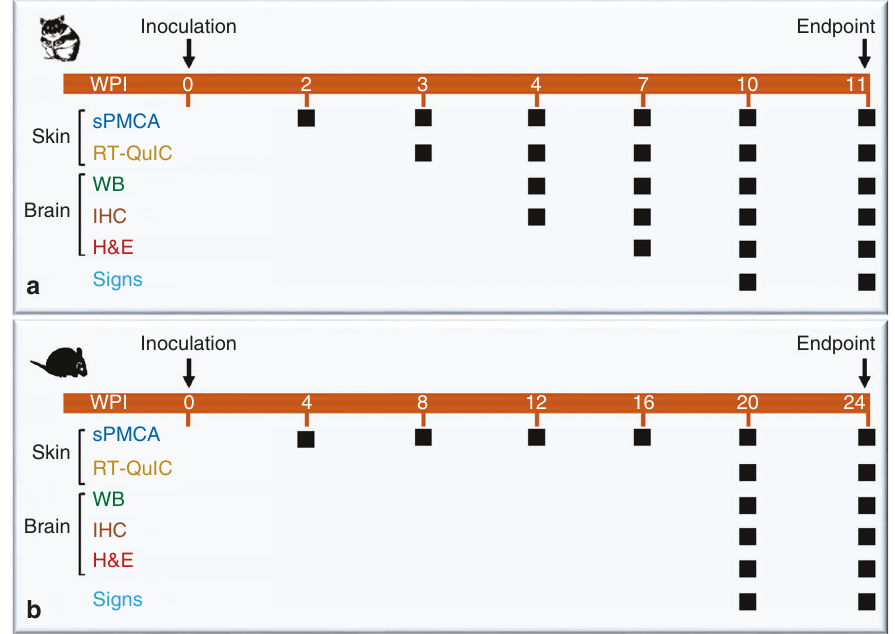
Fig. 8 Schematic diagram of time-points with detectable PrP Sc , brain pathology, or signs. a 263K-inoculated hamsters were assessed at different weeks post inoculation (wpi) from day 0 to endpoint at 11 wpi. b sCJDMM1-inoculated Tg40h mice were assessed at different wpi from day 0 to endpoint at 24